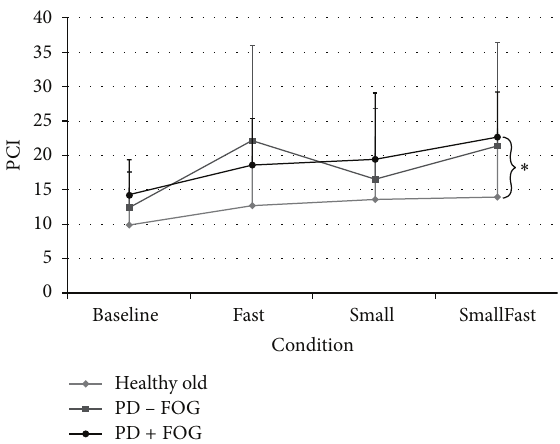
Figure 4: Phase coordination indices (PCI) for PD − /+ FOG and healthy older adults. ∗ Group significantly different, 𝑃 < 0.004